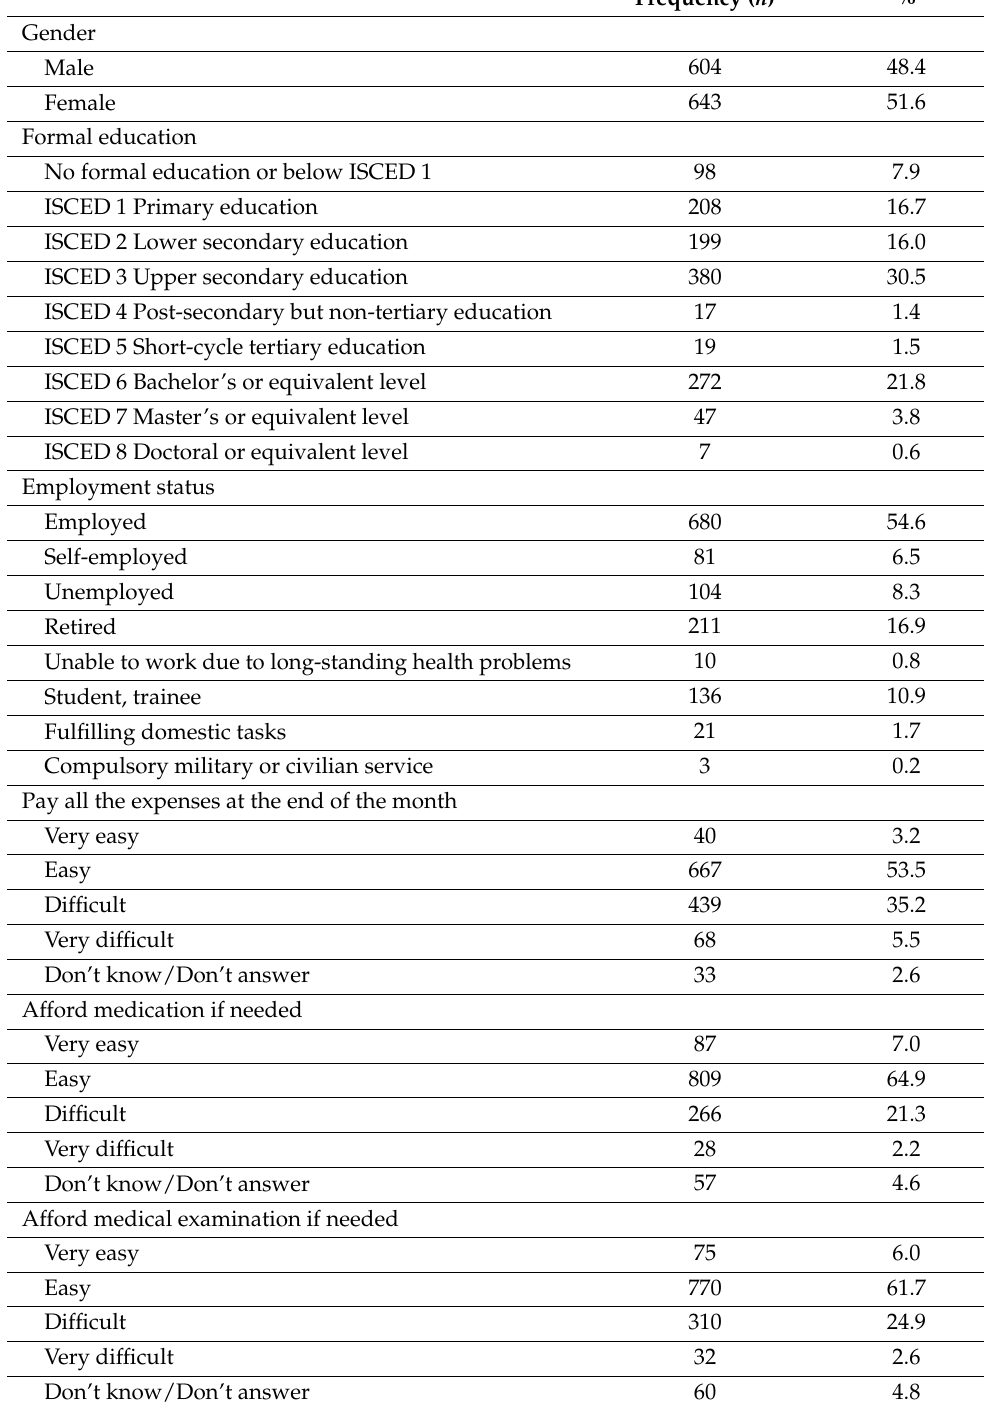
Table 2. Sociodemographic and income sufficiency